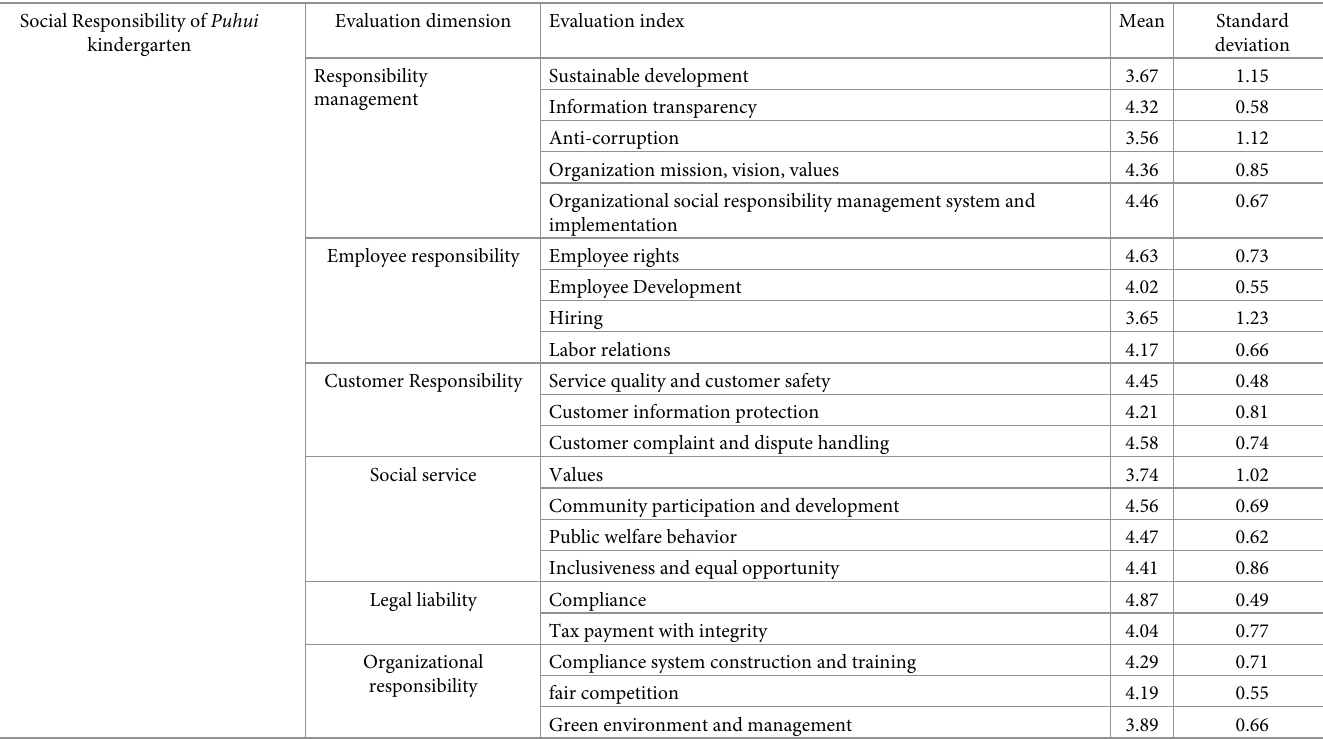
Table 2. Screening of social responsibility evaluation indexes of Puhui kindergartens. Social Responsibility of Puhui